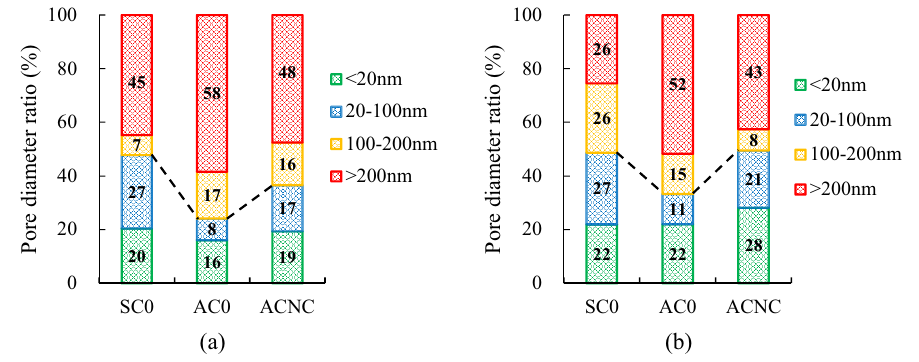
Figure 8: Pore diameter distributions in samples at di ff erent ages ( a ) 28 d ( b ) 300